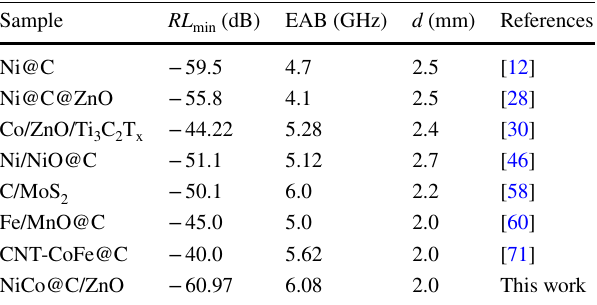
Table 1 electromagnetic wave absorption performance of typical composites